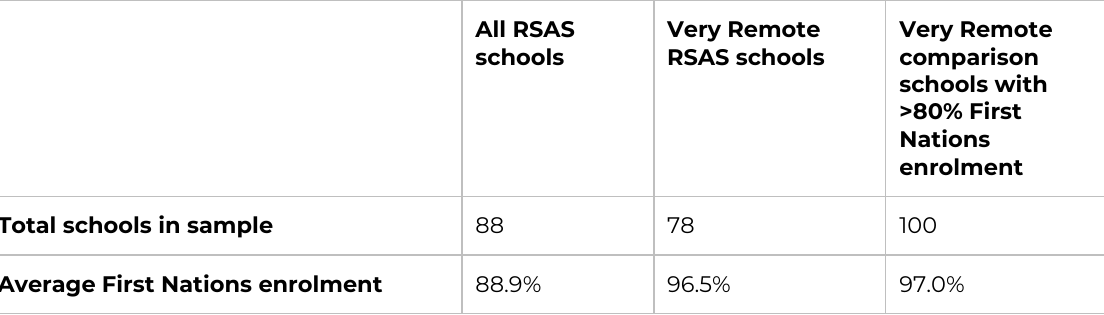
Table 2: Number of schools RSAS sample, Very Remote RSAS sub-set and comparison schools (Very Remote with >80% First Nations Enrolment) All RSAS